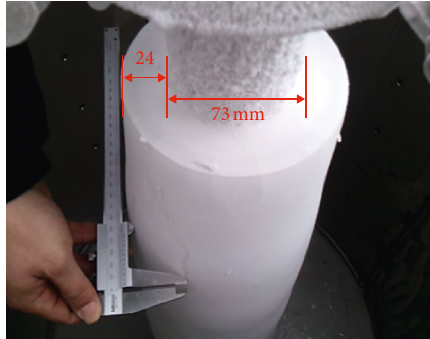
Figure 4: Ice column after 55min injection of LN